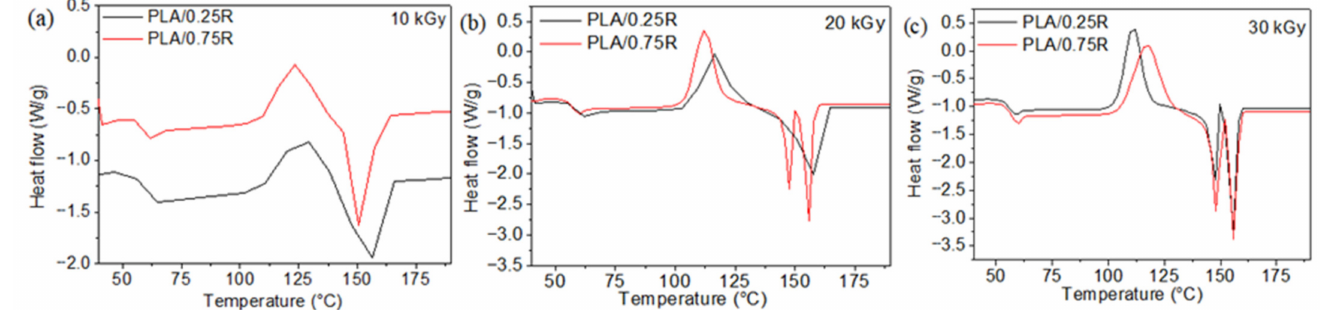
Figure 6. DSC curves of the PLA/0.25R and PLA/0.75R samples irradiated at 10 ( a ), 20 kGy ( b ), and 30 kGy ( c ). Recorded in the 2nd heating run.